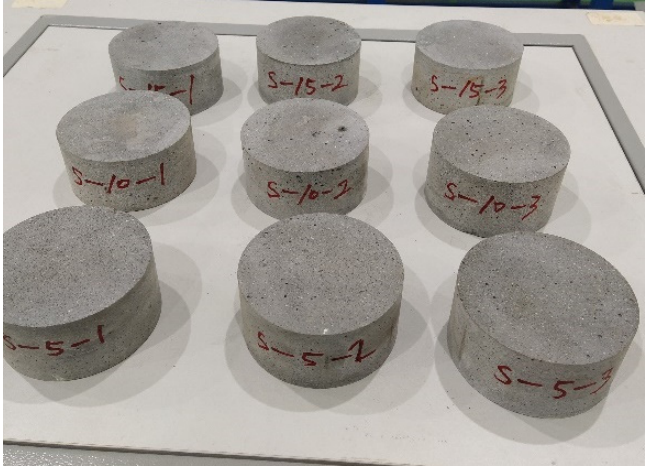
Figure 1. Physical image of processed